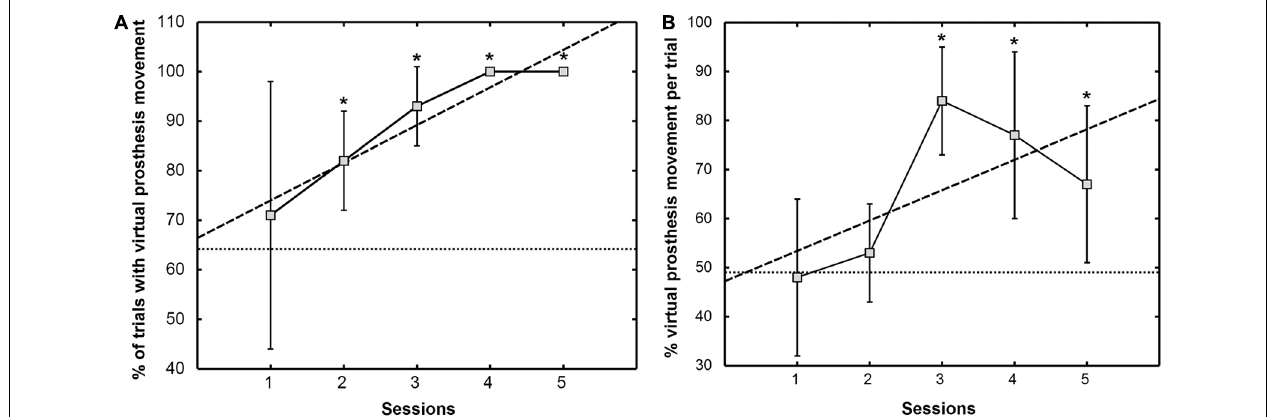
FIGURE 5 | Percentage of trials with virtual prosthesis movement (A) and percentage of average movement time of the virtual prosthesis divided by the total feedback duration phase (B). The mean ± SD of the performance measure per session is indicated by solid lines. Dashed lines show the trend line determined by linear least square regression.The mean